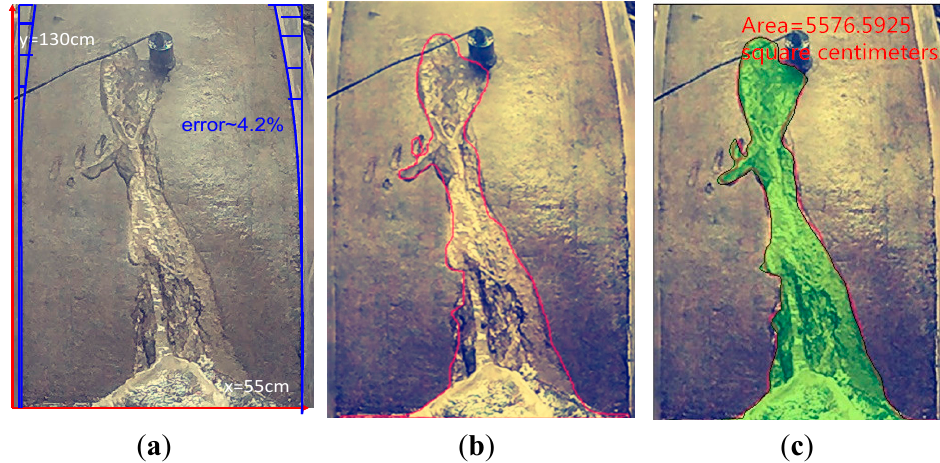
Figure 3. Area calculation by AutoCAD (soil Sample 1 and rainfall intensity-65 mm/h): ( a ) establishment of coordinate; ( b ) extraction of contour; and ( c ) calculation of